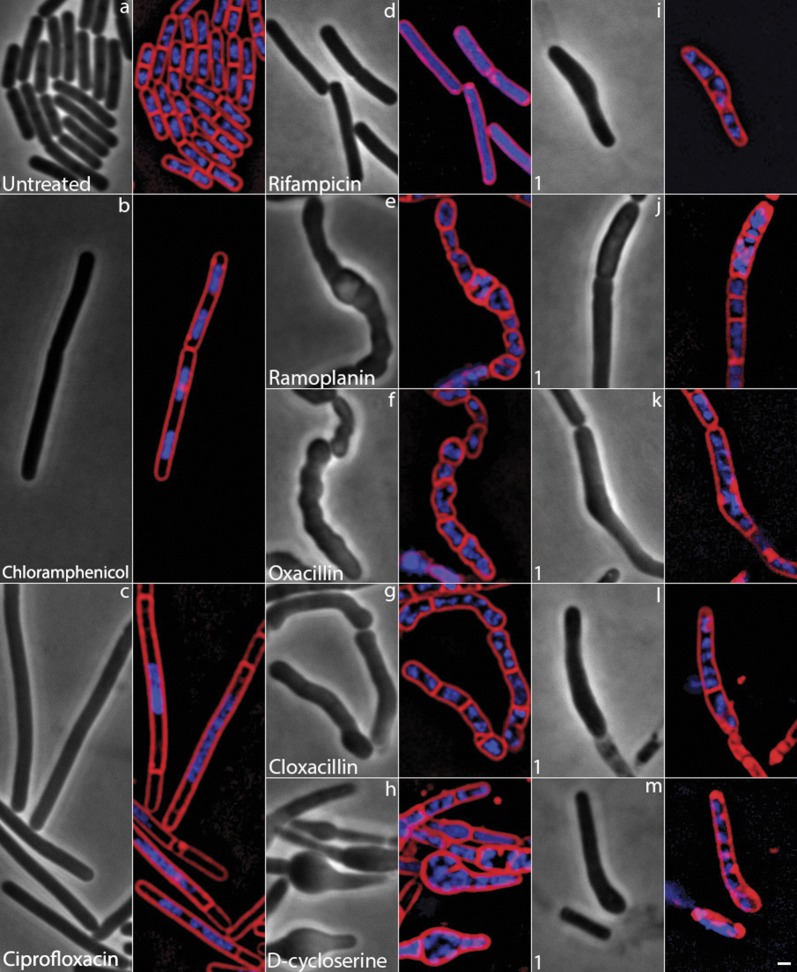
Bacterial cytological profiling of compound 1 against Bacillus subtilis.In Bacillus subtilis compound 1 induces cell shape defects similar to cell wall biosynthesis inhibitors. All cells were grown at 37 °C in LB-MSM and are shown at two hours. (a) Untreated cells. Treatment with (b) chloramphenicol at 5×MIC (10 μg/mL), (c) ciprofloxacin at 5×MIC (0.75 μg/mL), (d) rifampicin at 5×MIC (0.25 μg/mL), (e) ramoplanin at 1×MIC (0.375 μg/mL), (f) oxacillin at 5×MIC (1.87 μg/mL), (g) cloxacillin at 1×MIC (0.46 μg/mL), (h) D-cycloserine at 1×MIC (37.5 μg/mL), (i-m) Cells treated with compound 1 at 2.5×MIC (7.5 μg/mL). Compound 1 shows subtle cell shape defects consistent with cell wall inhibition. Cells are stained with FM 4−64 (red), DAPI (blue), and SYTOX Green (green). Scale bar is 1 μm.